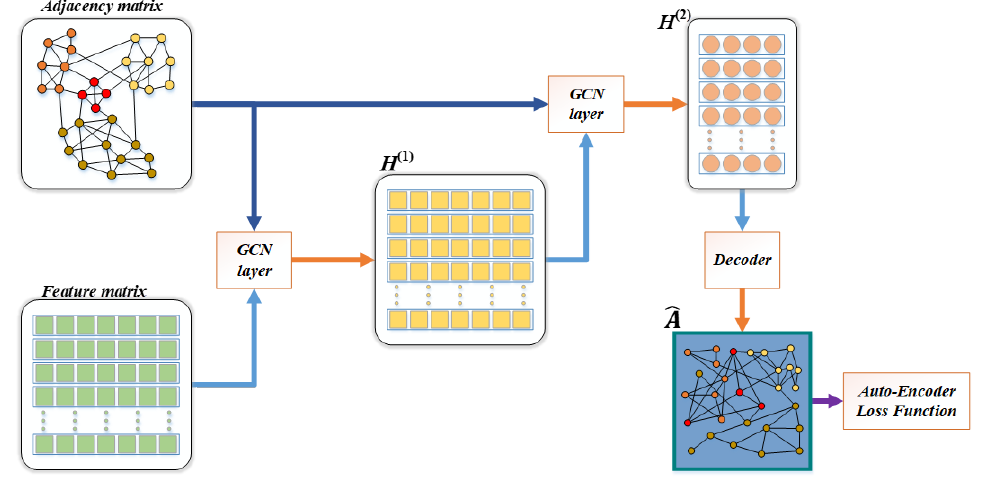
Figure 3. Graph convolutional-network-based auto-encoder